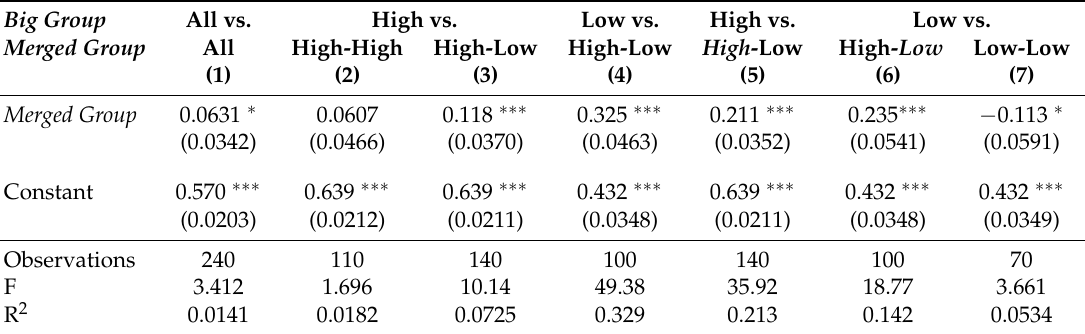
Table 4. Linear regressions: between treatment helping rates in Part B Big Group All